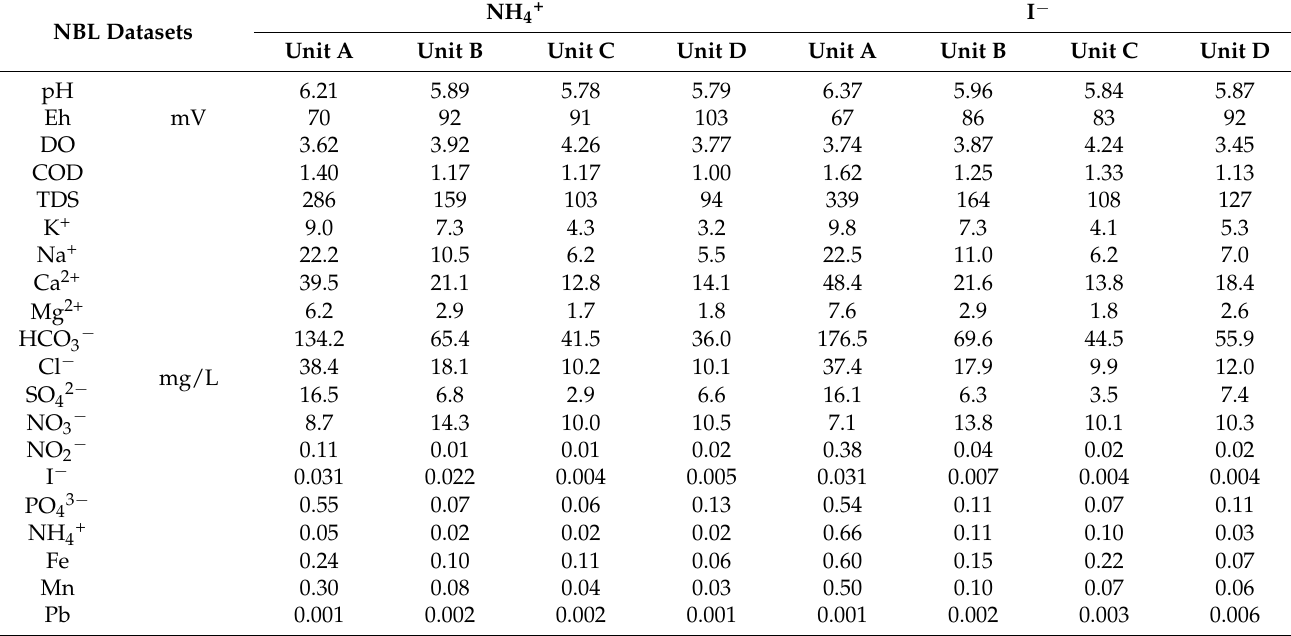
Table 1. Mean concentrations of physicochemical parameters in residual datasets in various ground- water